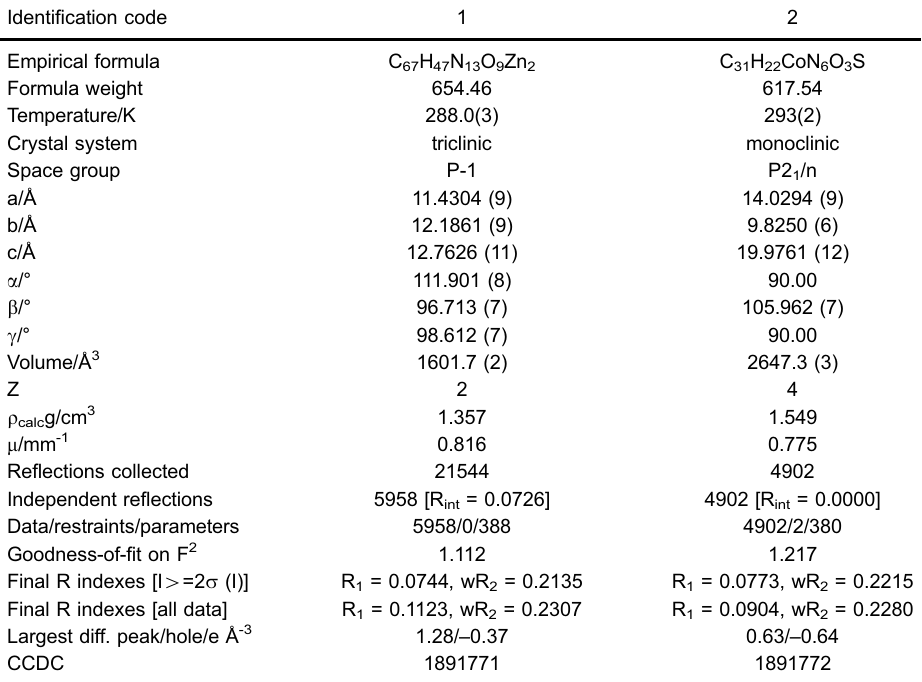
Table 1. Crystal data and structure re fi nements for compounds 1 and